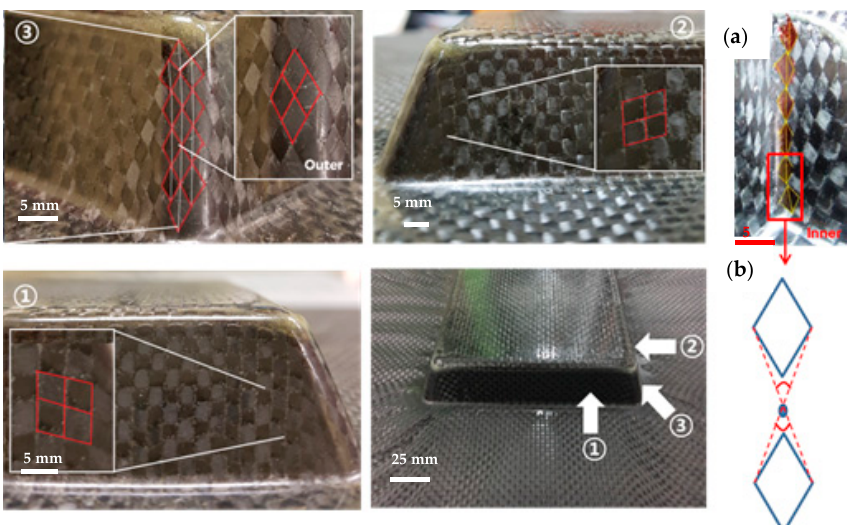
Figure 9. Shear-dominated regions of the PW carbon prepreg at ① , ② and ③ , ( a ) Shear angle measurement at the inner corner of ③ , ( b ) Averaging the shear angle by connecting imaginary lines between two rhombic shapes.